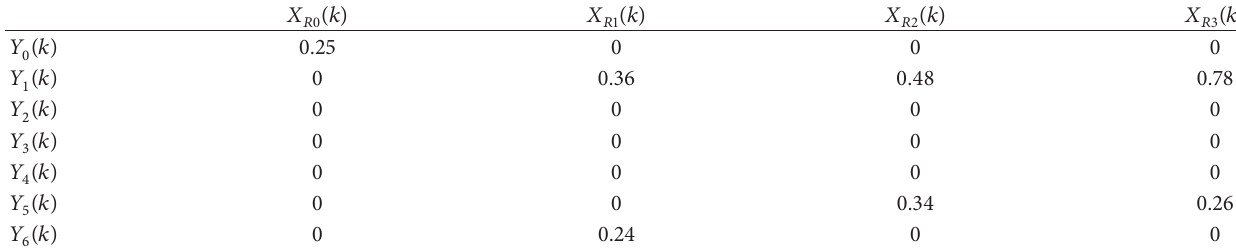
of the sensitivity of reactive stimuli. OM